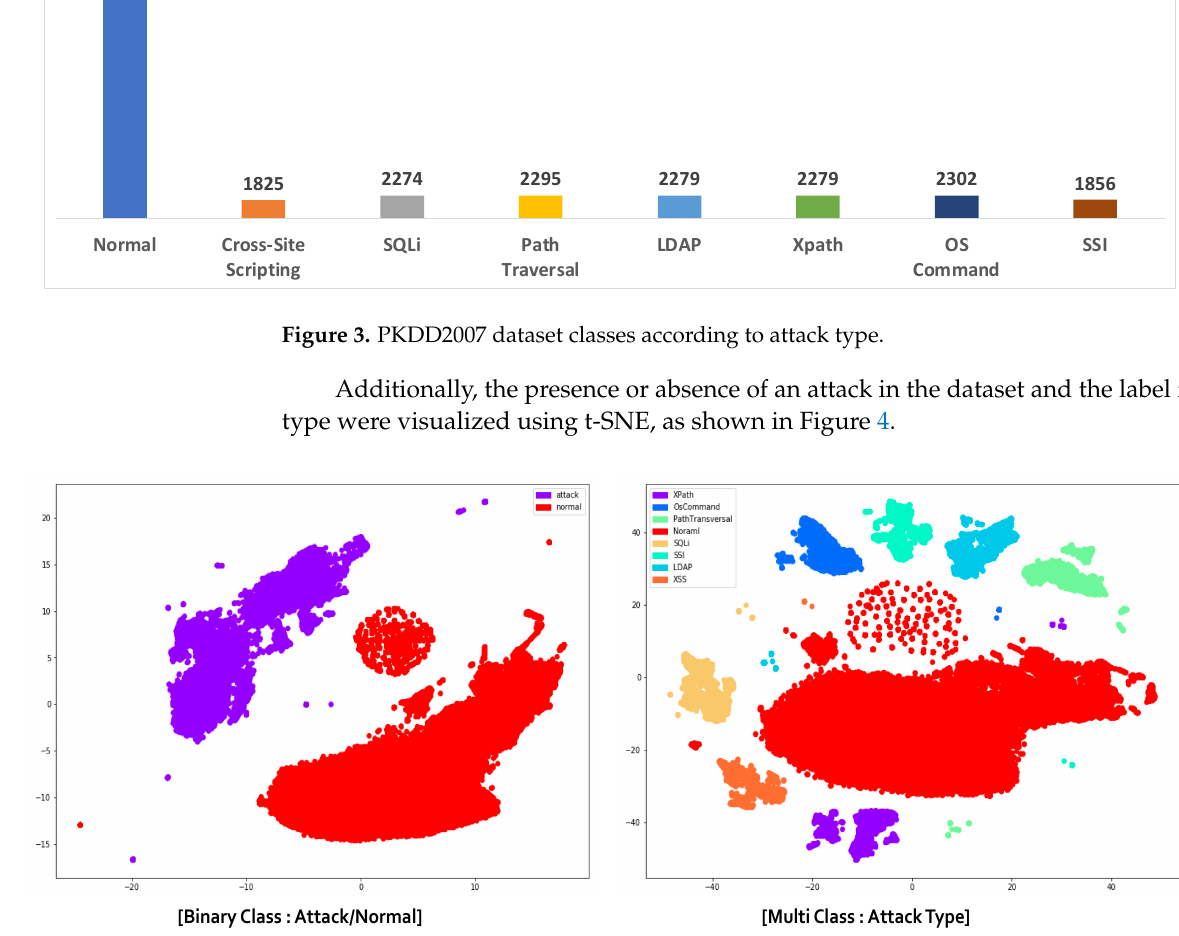
Figure 4. Results of t-SNE visualization for the PKDD2007 dataset.